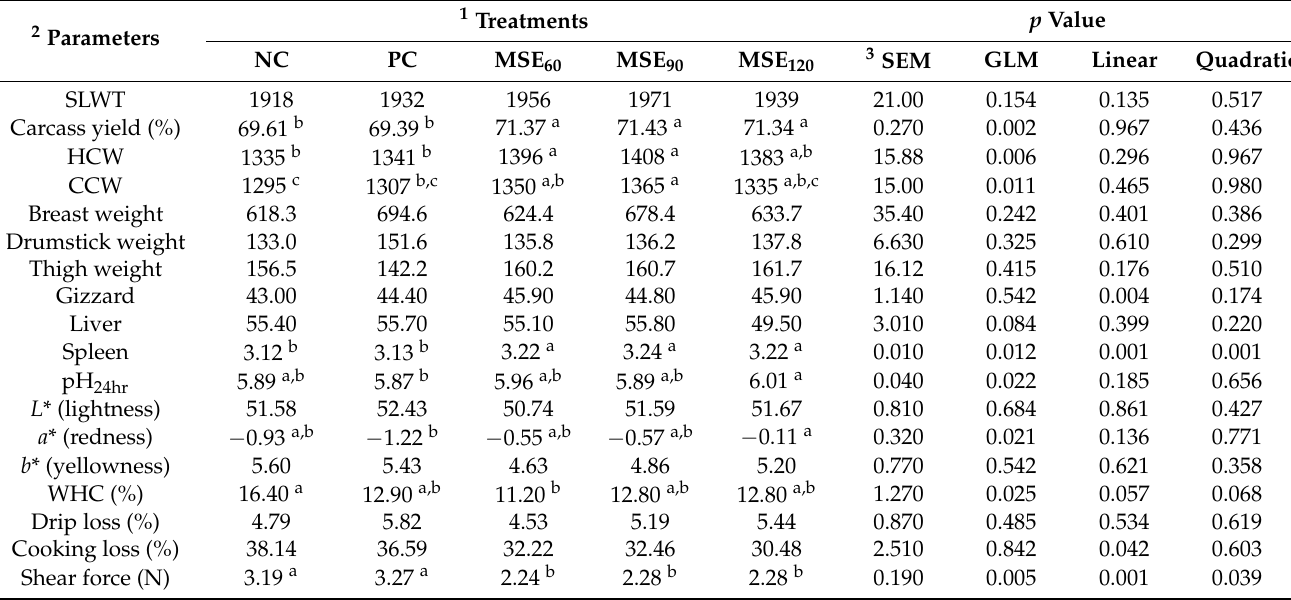
Table 1. Carcass and meat quality characteristics (g, unless otherwise stated) of six-week-old broiler chickens ( n = 125) orally administered with varying levels of moringa seed extract (MSE) in drinking